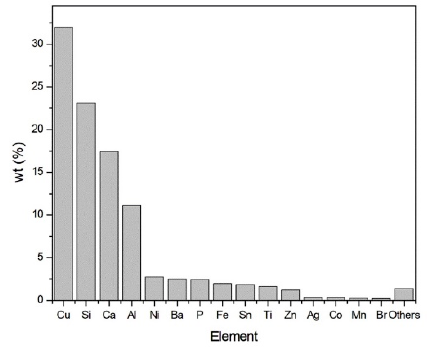
Figure 2. Chemical composition of PCB specimen determined by